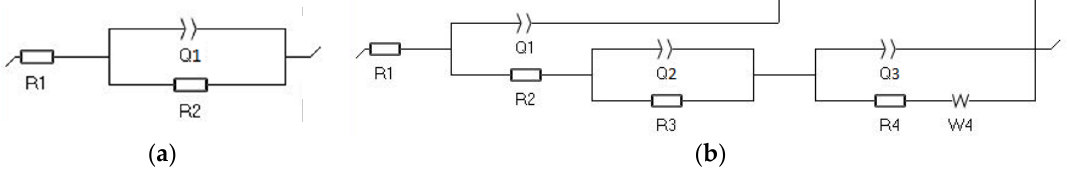
Figure 16. Corresponding equivalent electrical circuits for fitting the impedance data of ( a ) uncoated pure aluminum and ( b ) PEO coatings.